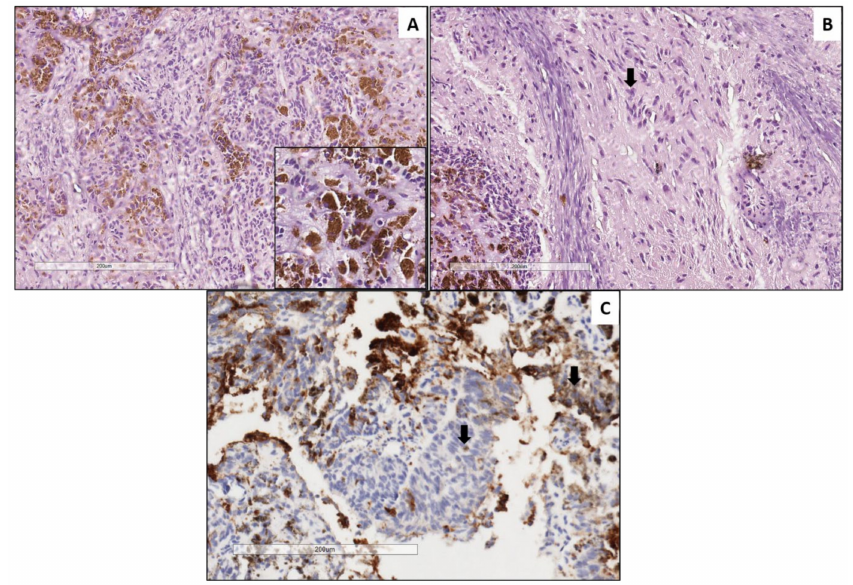
Figure 1. Pineal anlage tumor (PAT, primary specimen). Neuroepithelial component characterized by pineoblastoma-like nests of small round blue cells with hyperchromatic nuclei admixed with tubular structures composed of epithelioid cells containing melanin pigment (inset) ( A ). Ganglion cells charac- terized by round nuclei and abundant eosinophilic cytoplasm (arrow) ( B ). Positive immunoreactivity for synaptophysin in a cytoplasmic granular pattern (arrow) ( C ).